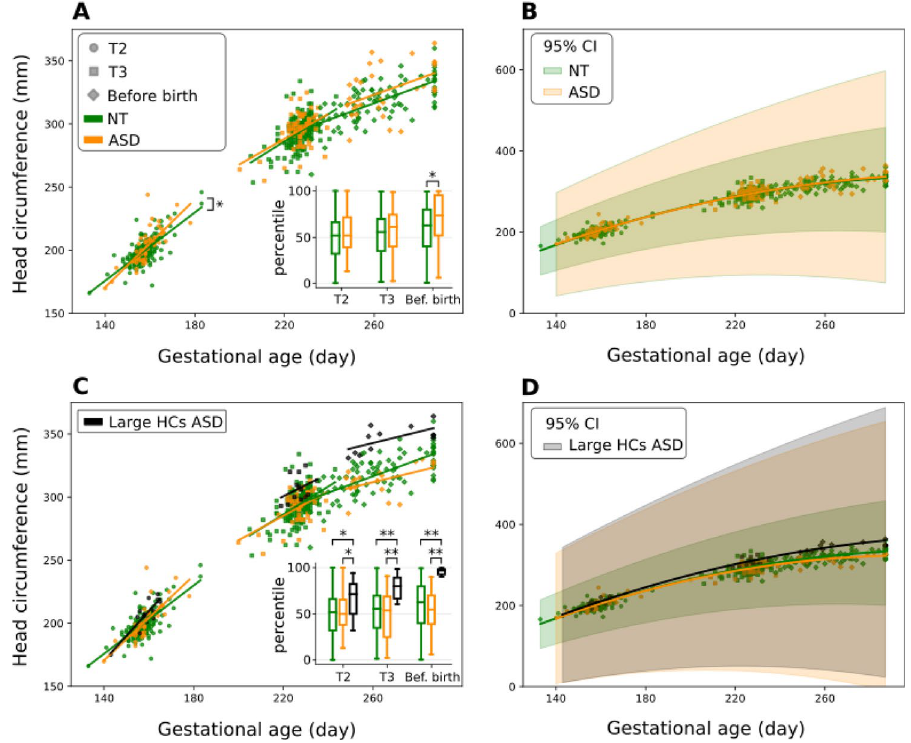
Figure 4. Head circumference (HC) growth is slowed down during development in NT and ASD, but shortly before birth ASD HC is bigger than NT HC. The HC in NT (green) and ASD (orange) groups is depicted versus the gestational age in T2 (circle), T3 (square) and shortly before birth (diamond) periods. ( A ) Linear regression analysis shows the growth of HC in T2 is significantly higher in ASD than NT ( p < 0.05). Also, ASD HCs are bigger than NT shortly before birth ( p < 0.05) as shown in the boxplot (center line, median; box limits, upper and lower quartiles; whiskers, 1.5 × interquartile range). ( B ) The quadratic mixed effect model shows a similar progressive slowdown of HC of NT and ASD children towards birth. The 95% confidence intervals are shown for each curve. ( C ) A subpopulation of the ASD group with large HCs before birth was separated from the rest of the ASD group (black points). Linear regression analysis shows similar HC growth rates in the 3 groups. However, ASD fetuses with large HCs have significantly larger HCs than NTs in the 2nd and 3rd trimester and shortly before birth ( p < 0.05, p < 0.001 and p < 0.001, respectively). ( D ) The quadratic mixed effect model shows similar progressive slowdown of HC of NT, ASD and “Large HCs ASD” children towards birth. * p < 0.05, ** p <